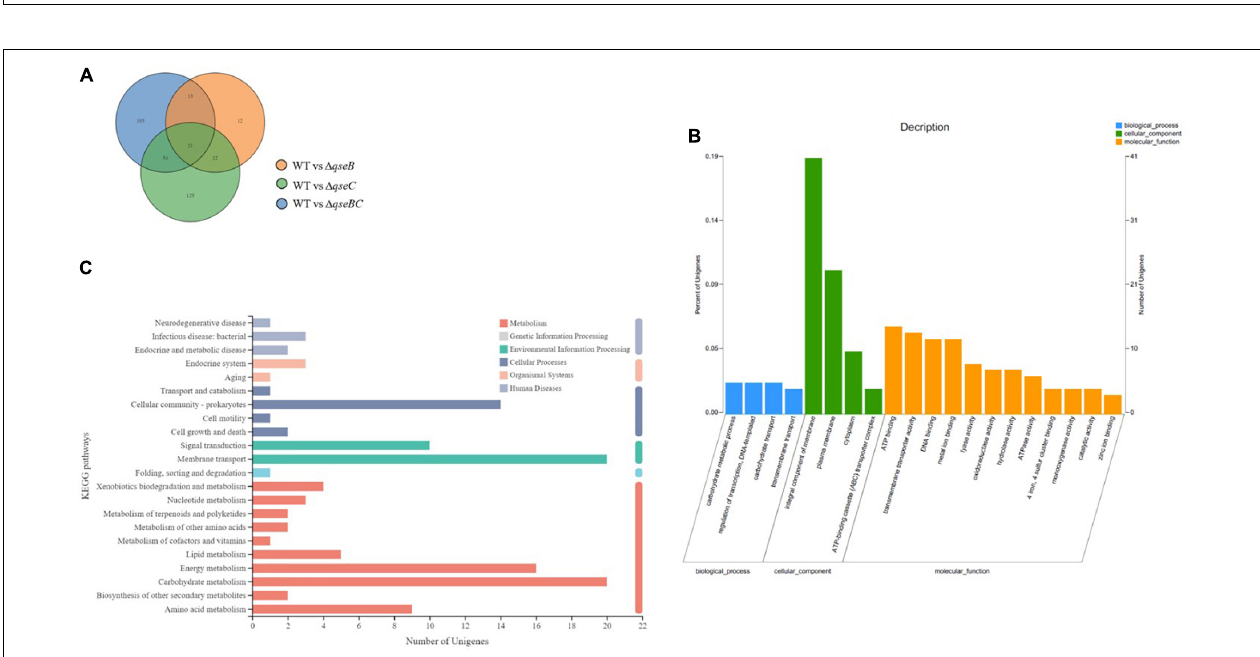
FIGURE 5 | Analysis of total RNA sequencing. (A) The Venn diagram shows the overlapped DEGs numbers across (cid:49) qseB , (cid:49) qseC and (cid:49) qseBC . (B) Significantly enriched GO terms of DGEs in the qseC mutant. (C) Significantly enriched KEGG pathways of DEGs in the qseC mutant.